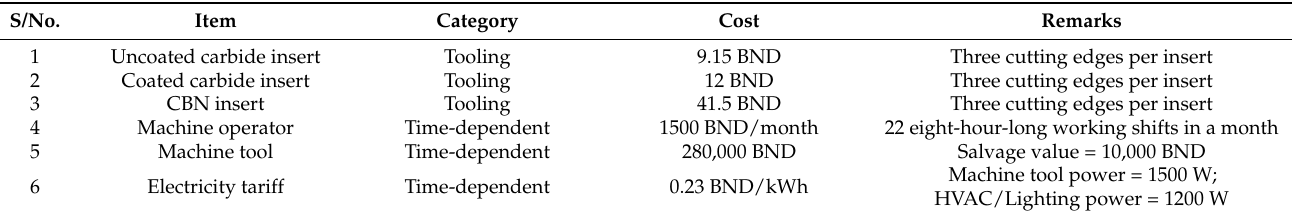
Table 1. Purchase/consumption cost of various items related to a turning process.